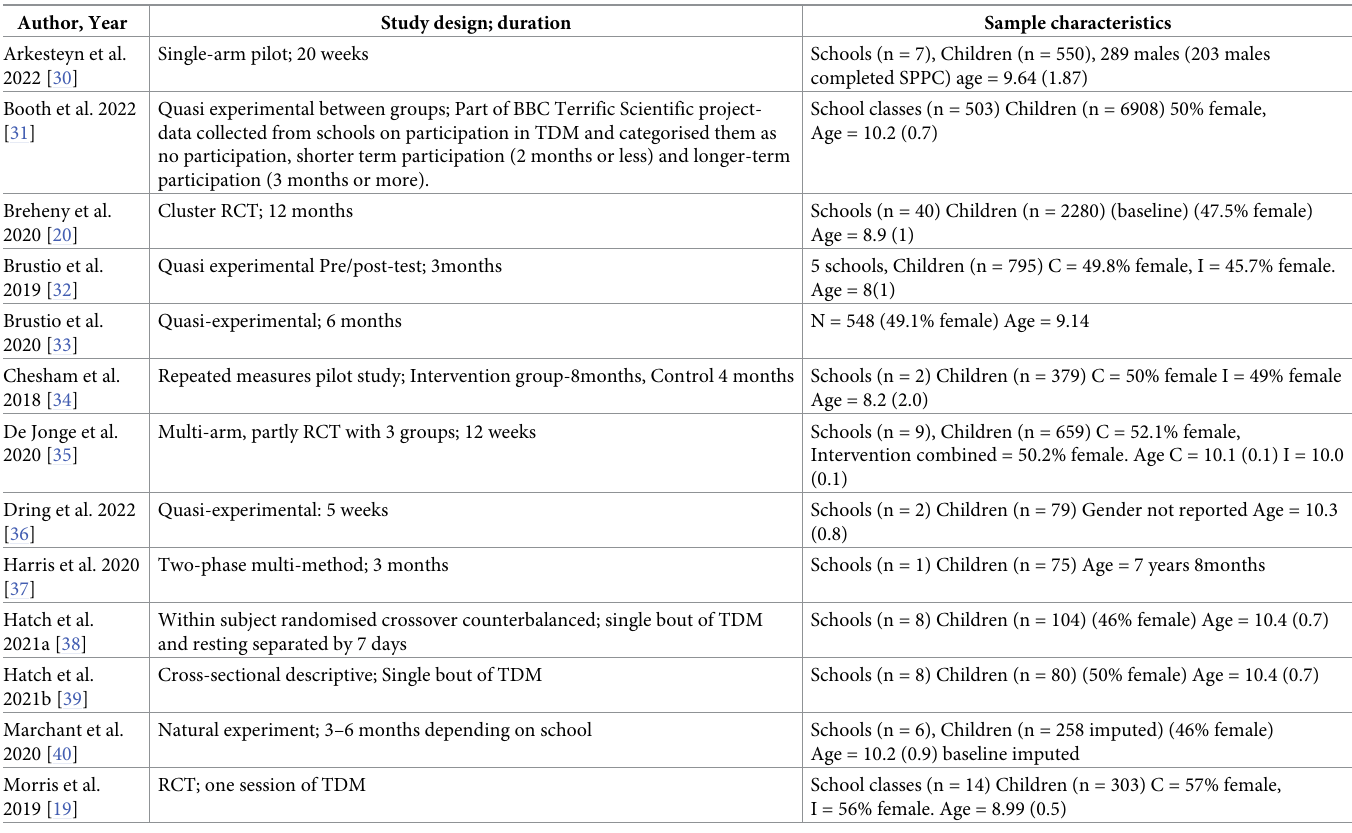
Table 2. Author, year, study design, duration and sample characteristics of included